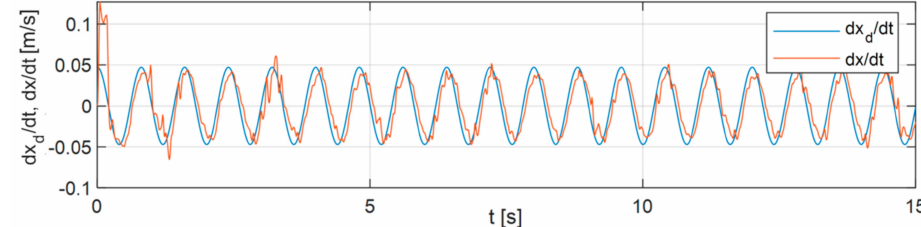
Figure 19. Set dx d / dt and realized dx / dt speeds of the passive part as functions of time.